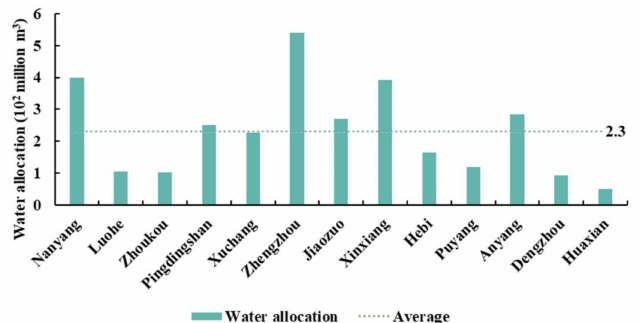
Figure 8. Water allocation of SNWD in Henan